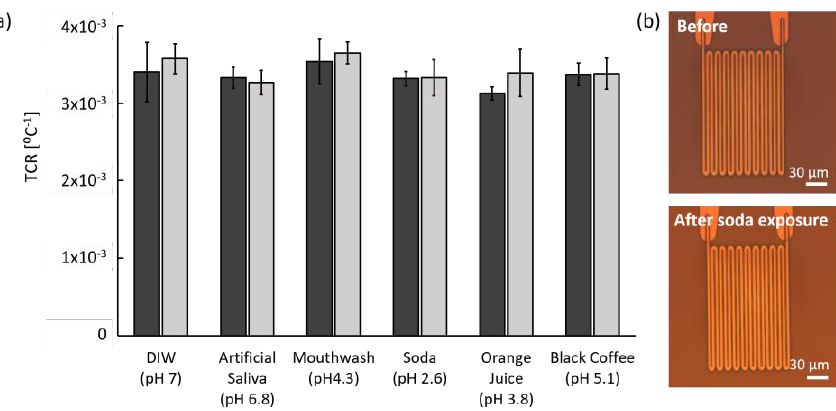
Figure 7. Chemical stability results before (dark gray) and after (light gray) chemical exposure. ( a ) Stable TCR values before and after immersion in DI water, artificial saliva, and four acidic solutions for 6 to 7 d (N = 19). Error bars represent the SD. ( b ) Example of microscopic polarized images of the sensor surface before and after exposure to soda for 7